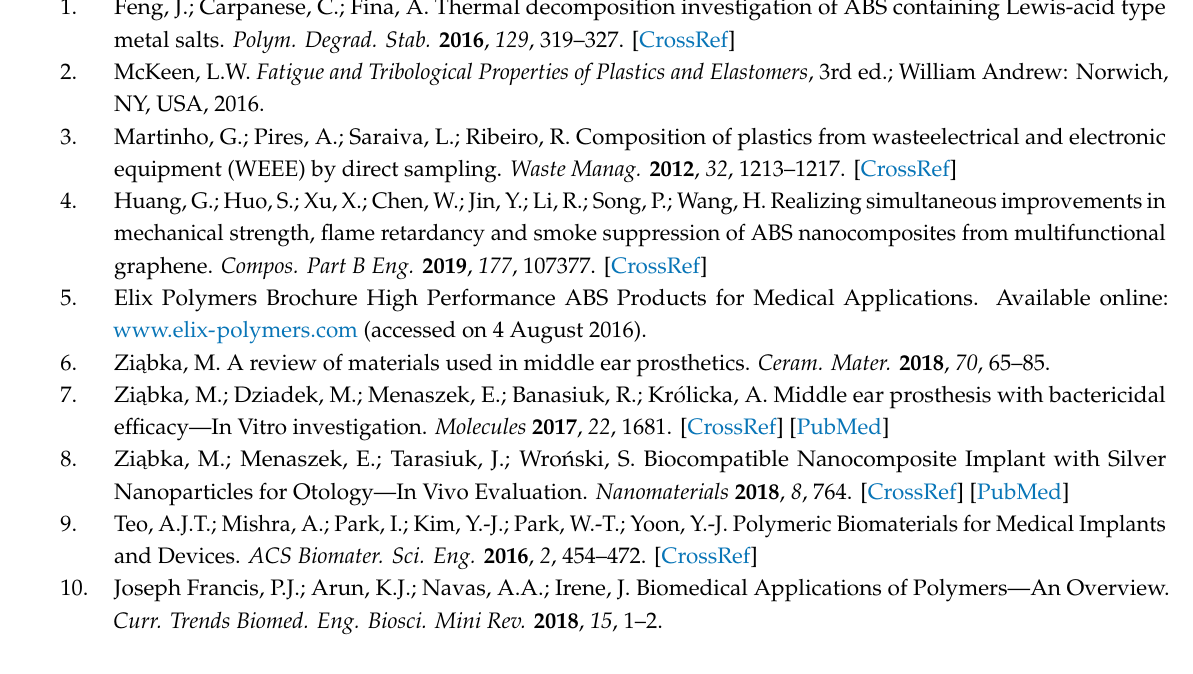
Figure S1: Spectrum and mapping analysis of HD15 polymer containing 1 wt.% of silver nanoparticles (AgNPs) before and 24 months of